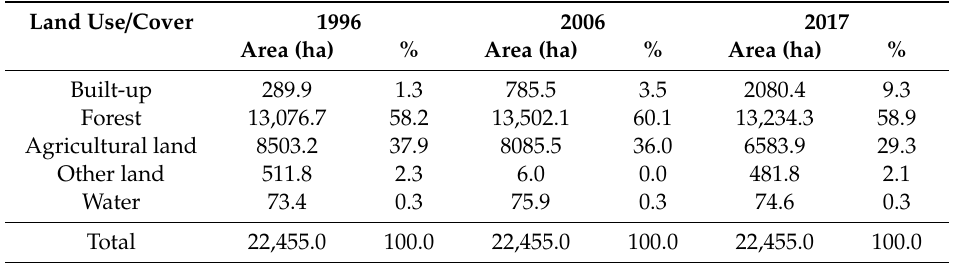
Table 5. Details of the land use and land cover changes in Nuwara Eliya in 1996, 2006, and 2017. Land Use / Cover